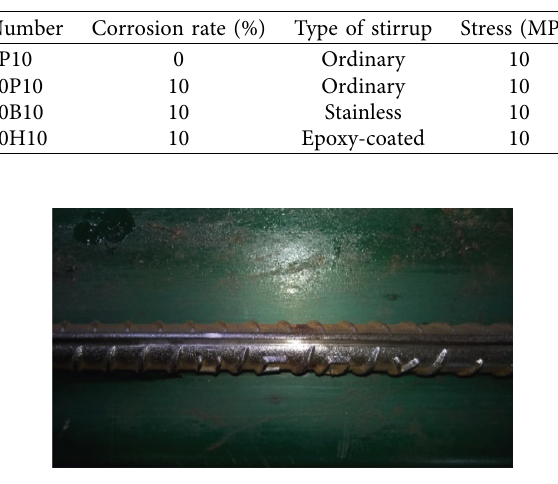
Table 2: Overview of specimens.